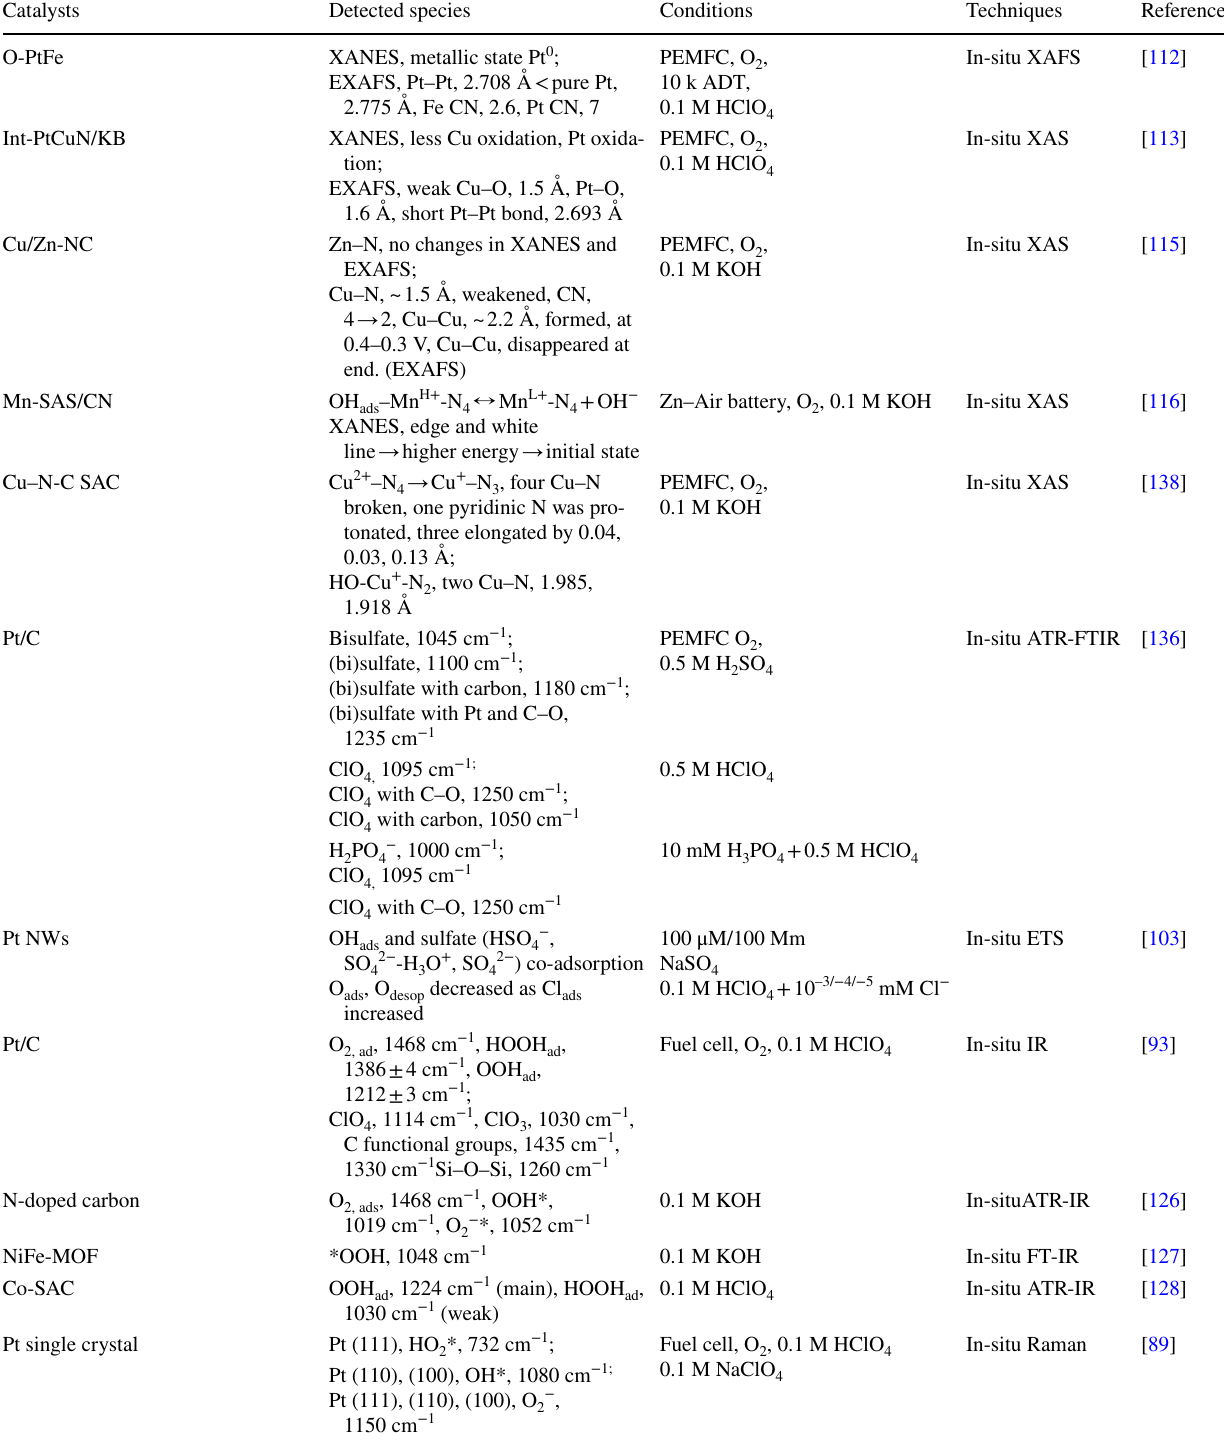
Table 3 Detected species on some represent electrocatalysts using various in-situ techniques